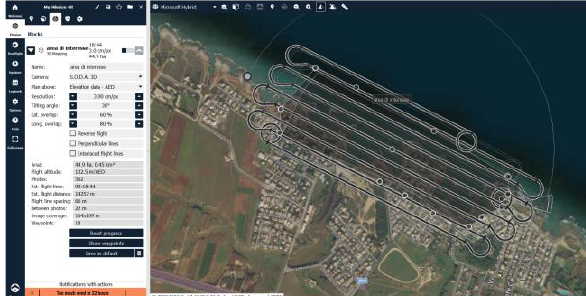
Figure 3. Screenshot of the eMotion flight plan of the surveyed